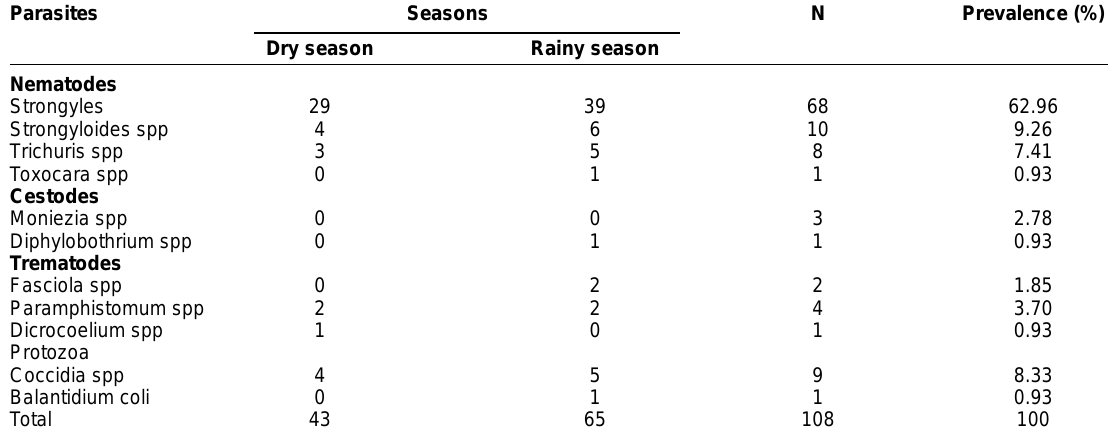
N = number of appearance of worm eggs and protozoan oocysts